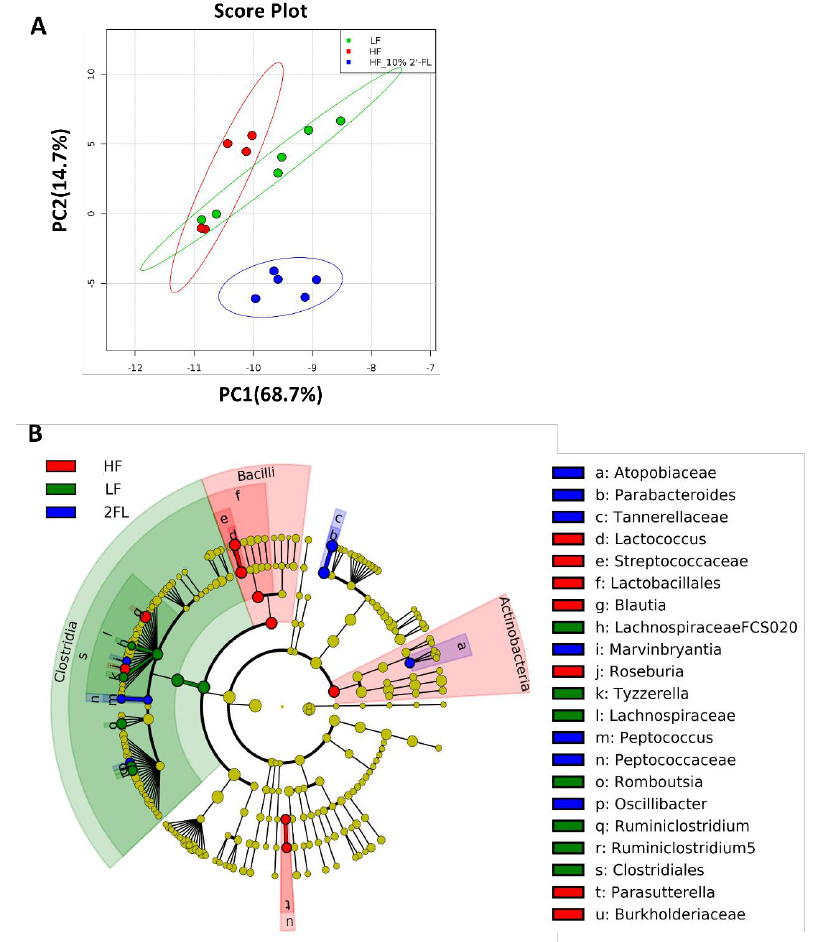
Figure 3. E ff ect of 10% 2 (cid:48) -FL supplementation on the composition of the gut microbiota. Principal components analysis on all taxonomic levels ( A ) of mice fed an LF, HF, or HF_10% 2 (cid:48) -FL diet for six weeks. the METAGENassist platform was used for multivariate statistical analysis. the linear discriminant analysis (LDA) e ff ect size (LEfSe) method was used to identify taxa that were significantly di ff erentially abundant for each group. Di ff erences in abundances among groups were assessed using Kruskal–Wallis test with Dunn’s post hoc test. n = 5~6 / group. Cladogram ( B ) generated from LEfSe analysis shows the most di ff erentially abundant taxa enriched in microbiota; blue indicating LF, green HF, red HF_2 (cid:48) -FL, and yellow indicating non-significance. the six rings of the cladogram stand for domain (innermost), phylum, class, order, family and genus. HF, high fat; HF_10% 2 (cid:48) -FL, HF with 10% 2 (cid:48) -FL ( w / v ) in drinking water; LEfSe, linear discriminant analysis e ff ect size; LF, low fat; 2 (cid:48) -FL,